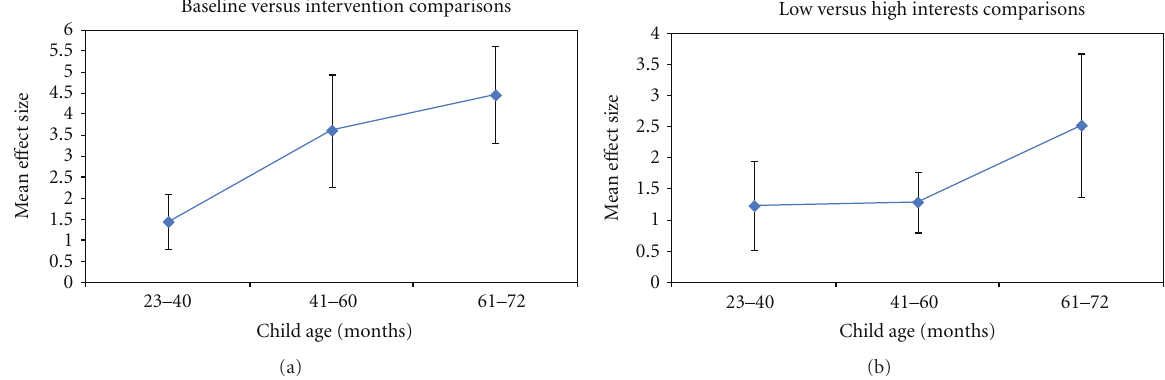
Figure 2: Influences of child age on the relationship between the interest-based interventions and the child outcomes ( Z s = 3 . 57 to 7 . 83, P s = . 0004 to . 0000 for all average e ff ect sizes).